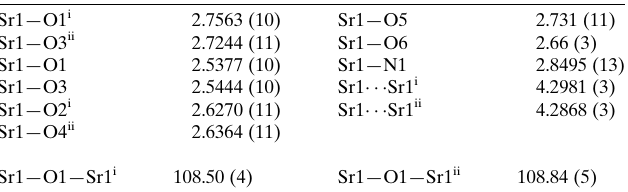
Table 1 Selected geometric parameters (A˚ , (cid:4) ).